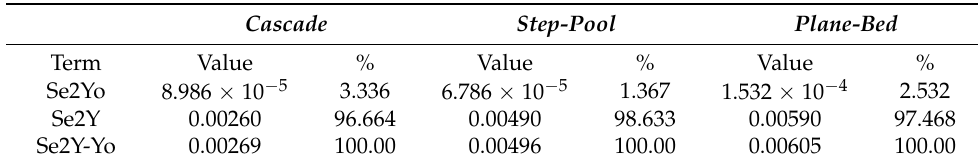
Table 7. Variance decomposition methodology for the studied morphologies.